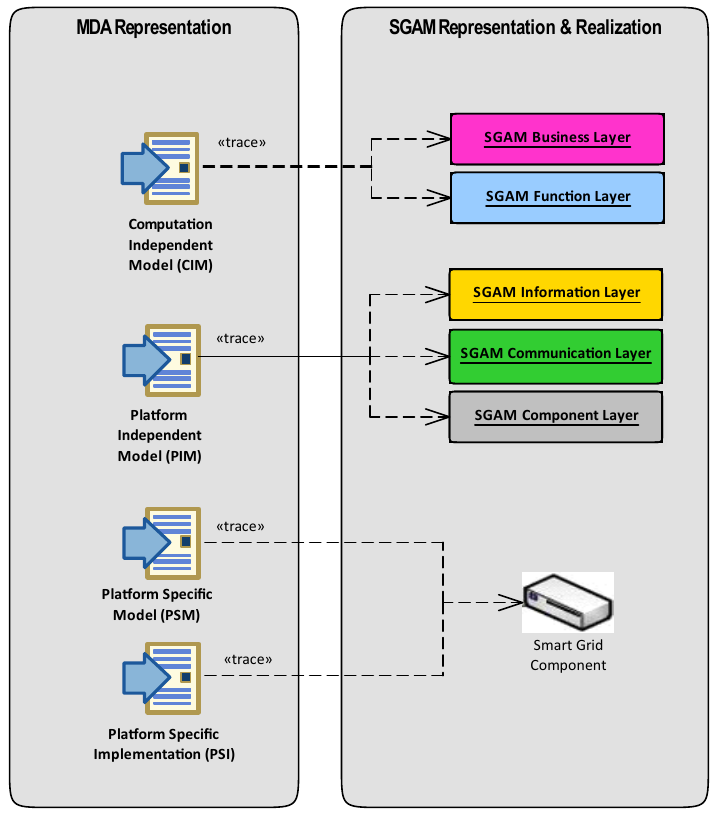
Figure 4. Mapping between MDA and